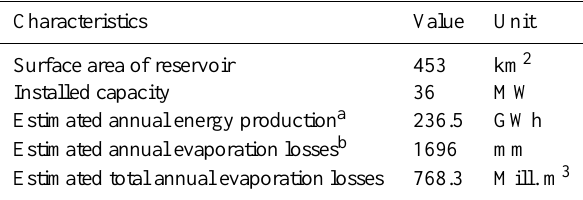
Table 4. Key characteristics of the reservoir and the hydropower production of SRPS. Source: Sauterleute et al. (2012).